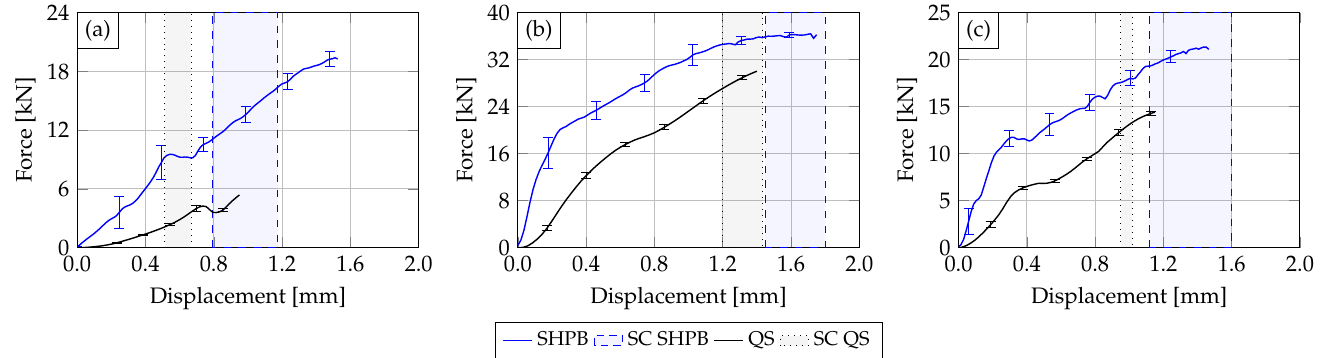
Figure 7. Comparison of the experimental results obtained from the quasi-static (solid black curve) and the dynamic characterization tests (solid blue curve) on the PA12 busbars with impactor V1 ( a ), V4 ( b ) and V5 ( c ). The according electrical SR ranges are also